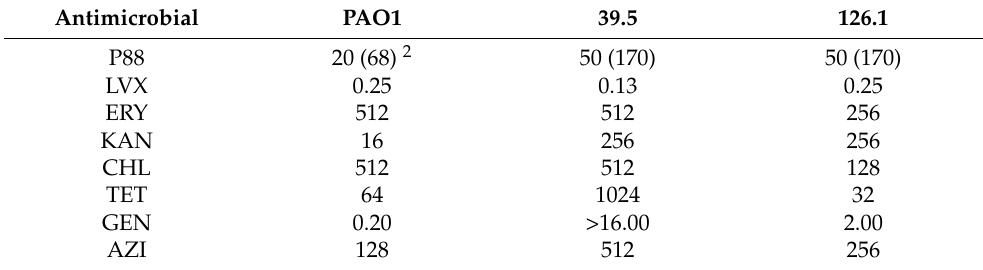
Table 1. MICs of P88 and a range of antibiotics 1 against P. aeruginosa strains. Antimicrobial